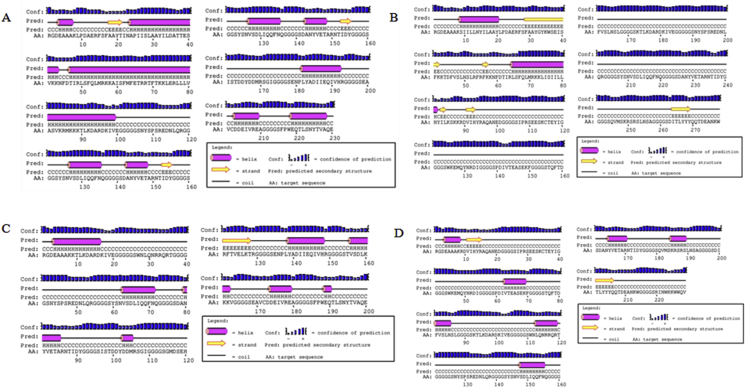
Graphical representation of secondary structure obtained for the multi-epitope constructs using PSIPRED server. A. Construct 1, 52.2% helix, 3.0% sheet and 44.8% coil, B. Construct 2, 10.43% helix, 9.71% sheet and 79.86% coil, C. Construct 6, 28.5% helix, 4.0% sheet and 67.5% coil and D. Construct 7, 19.2% helix, 4.8% sheet and 76.0% coil.